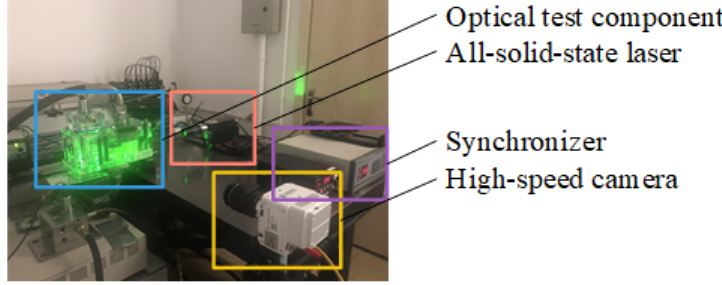
Figure 3. PIV experimental equipment and